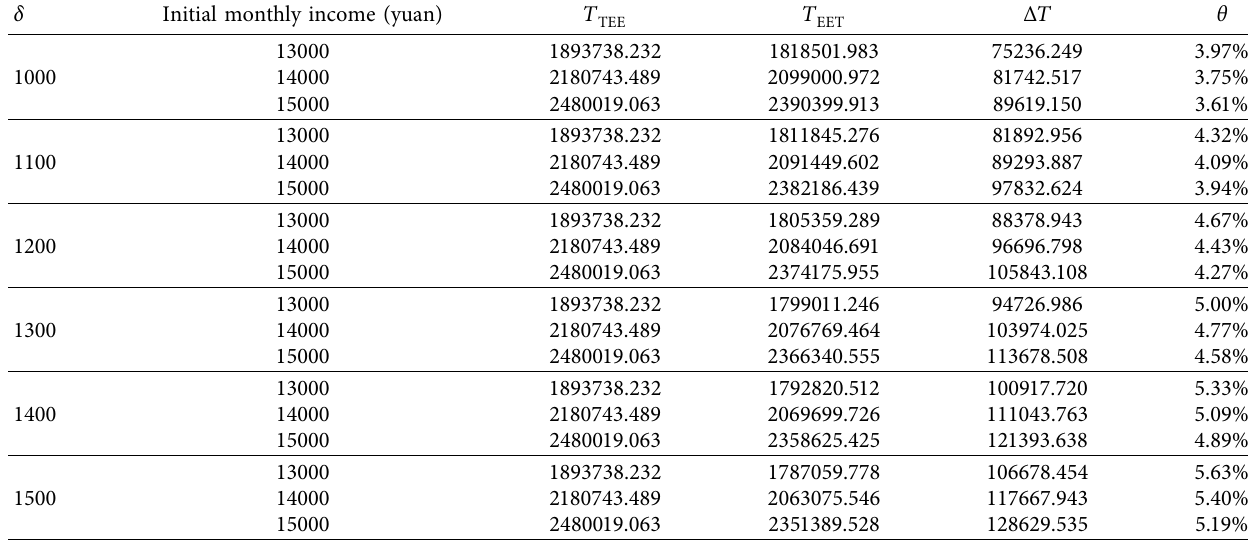
Table 5: Tax difference and tax-saving rate of the high-income group under the maximum premium limit.